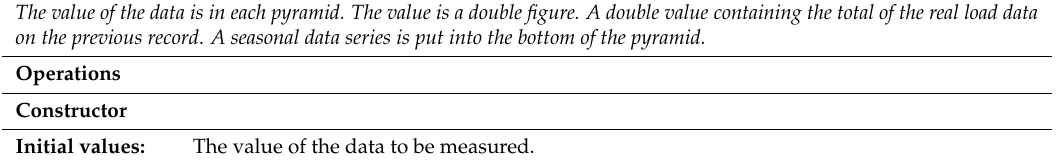
Table 1. The structure of Pyramid data classification